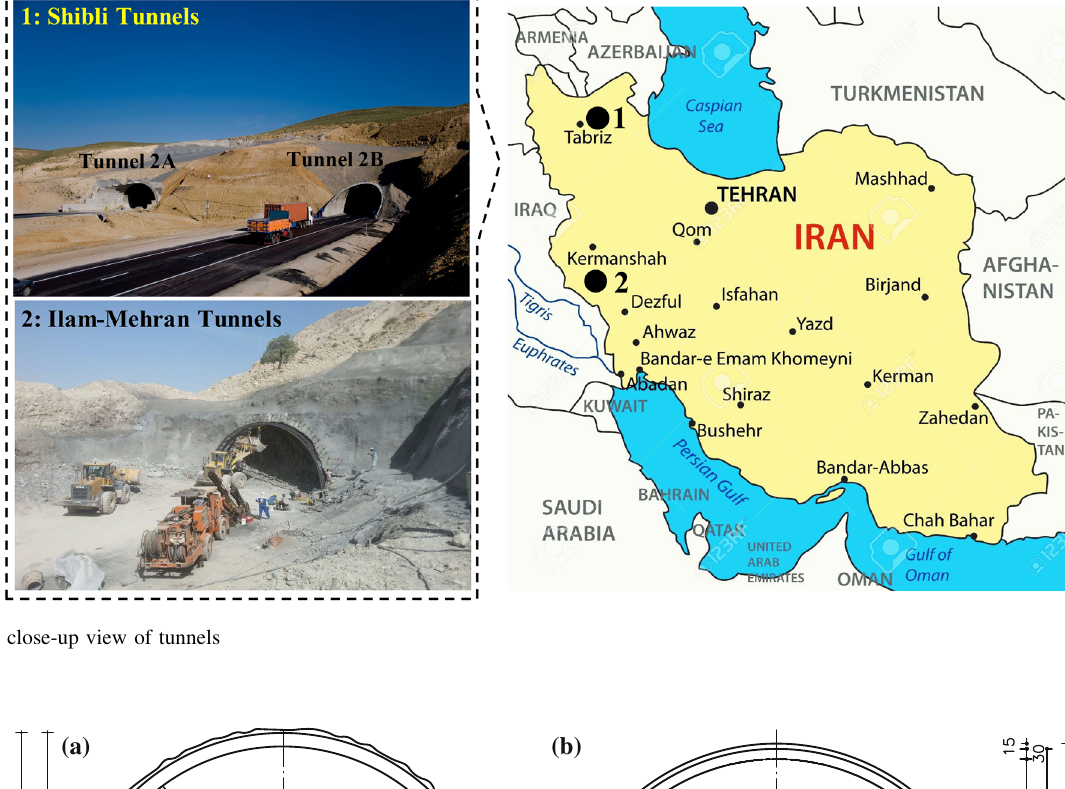
Fig. 2 A close-up view of tunnels